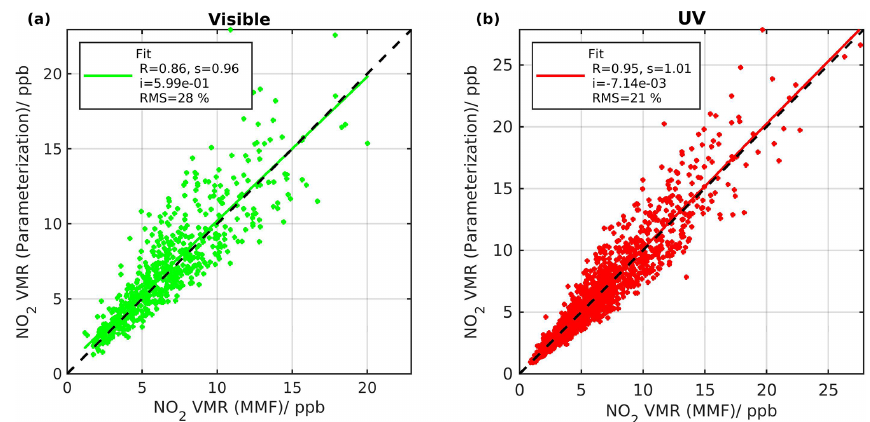
Figure 7. Comparison between MMF and parameterized NO 2 near-surface VMR at 477nm (visible, a ) and 360nm (UV, b ), as derived from the main azimuthal direction (i.e., 35.5 ◦ azimuthal direction).